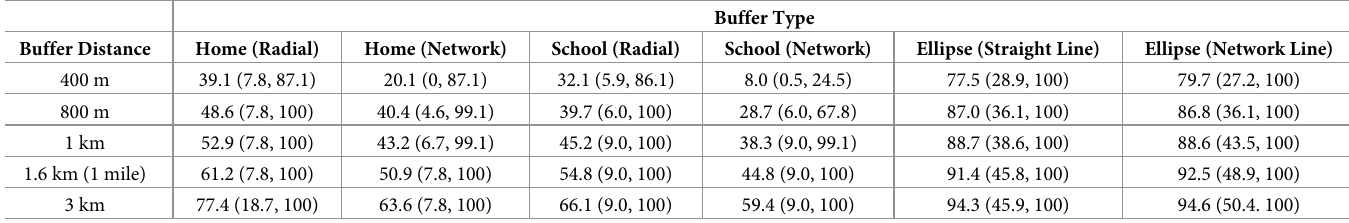
Table 5. The percentage of MVPA time undertaken within researcher-defined buffers (n = 34).